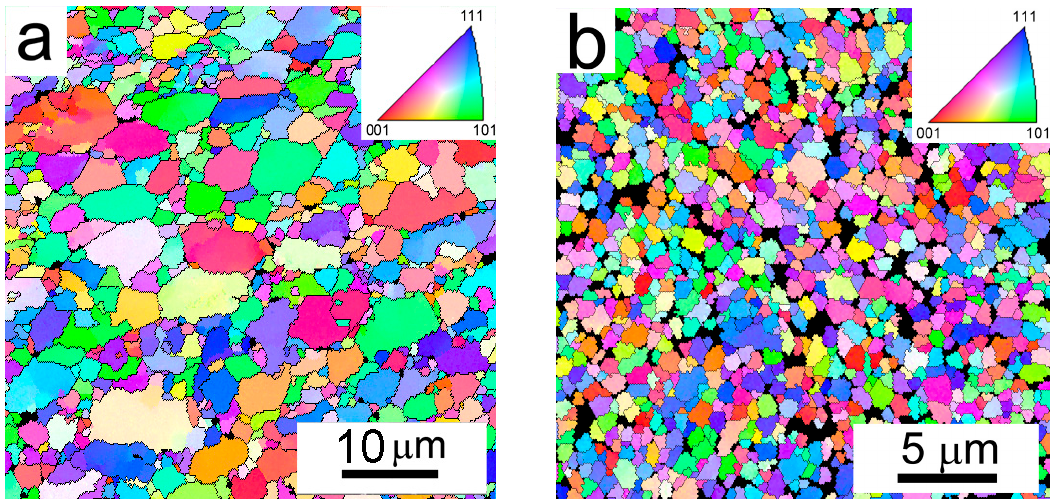
Figure 12. The microstructure of SPS compacts: ( a ) Al7075Zr_AC compact; and ( b ) Al7075Zr_MC compact, EBSD micrographs.